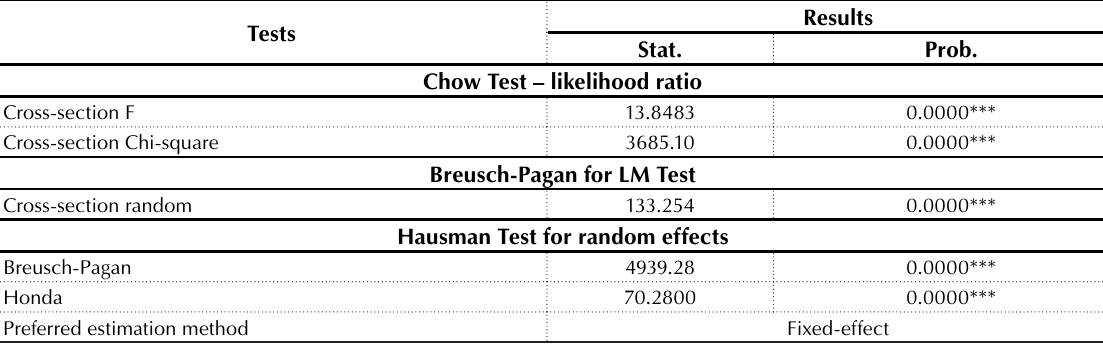
Table 5. Preferred estimation method for panel data